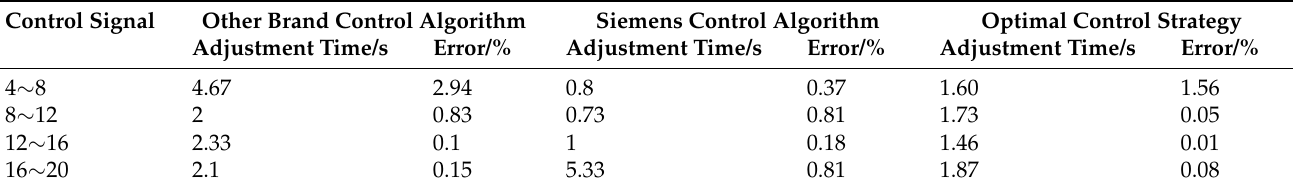
Figure 20. Large-range control algorithms comparison. Table 3. Comparison of large-range intake control algorithms.